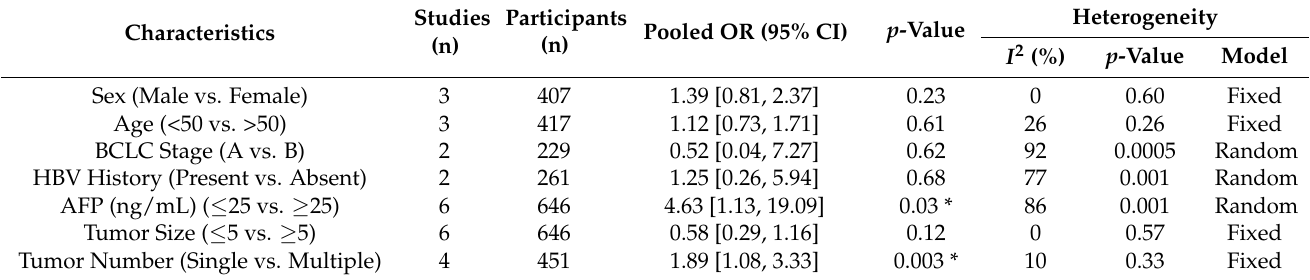
Table 2. Clinicopathological characteristics and pooled ORs associated with PD-1 expression.